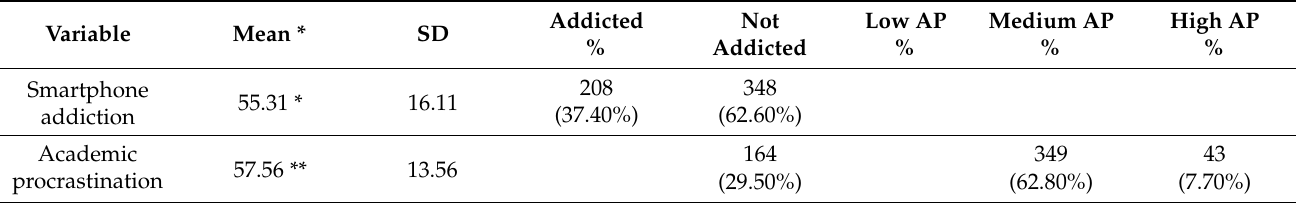
Table 1. The averages and rates of addiction to smartphones and academic procrastination among university